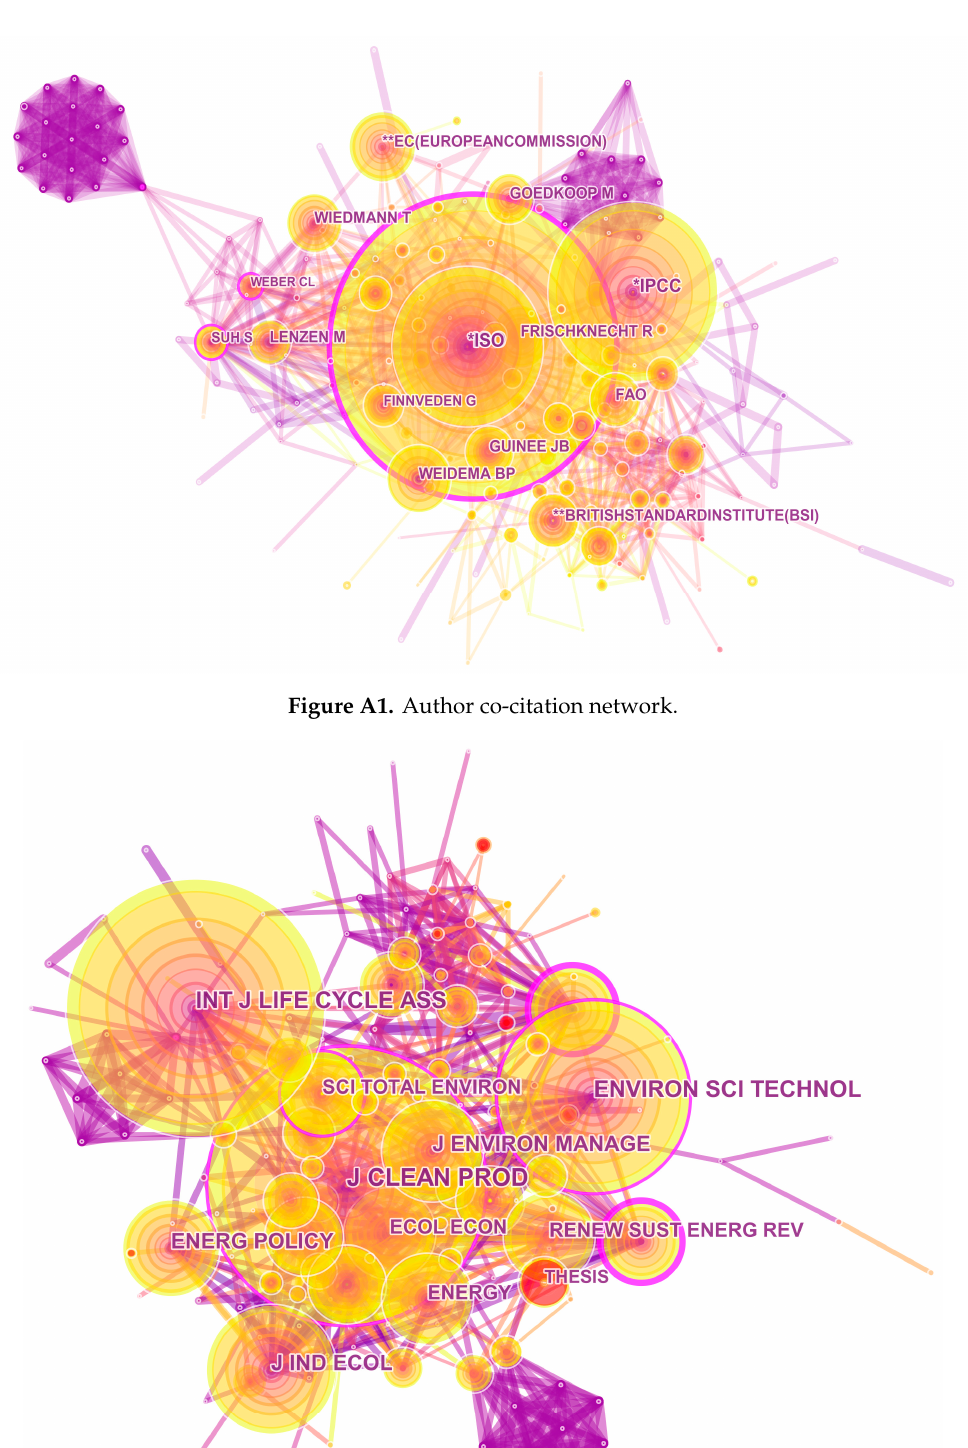
Figure A2. Journal co-citation network.